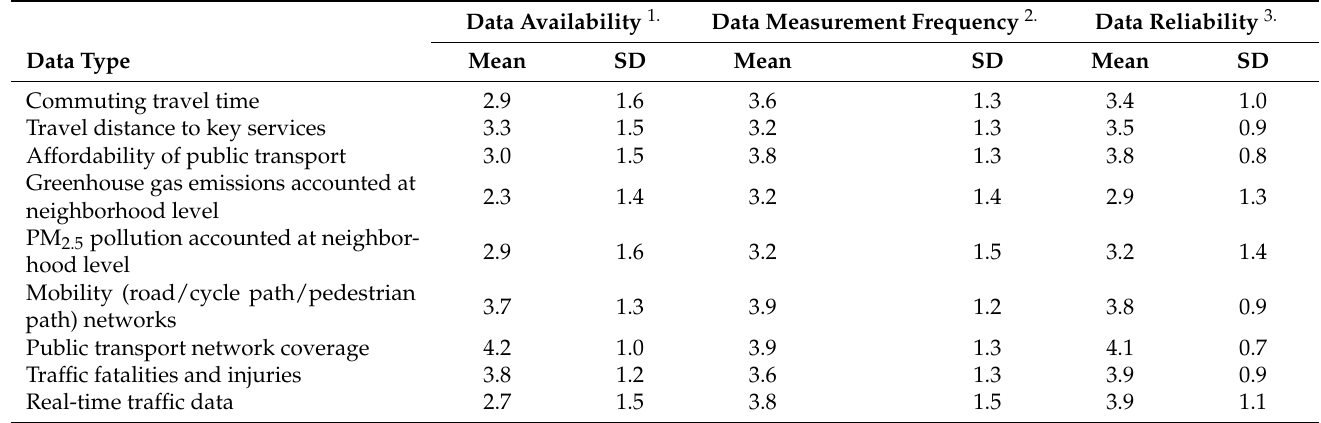
Table 4. Data availability, data measurement frequency, and data reliability for nine types of traffic- related data (mean and standard deviation, N = 23 respondents). Data Availability 1. Data Measurement Frequency 2. Data Reliability